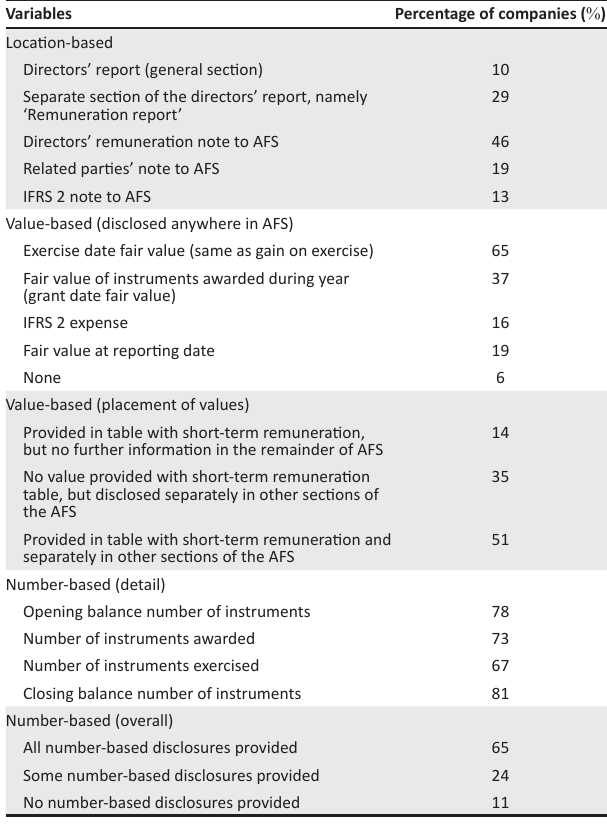
TABLE 2: Findings on disclosure of share-based